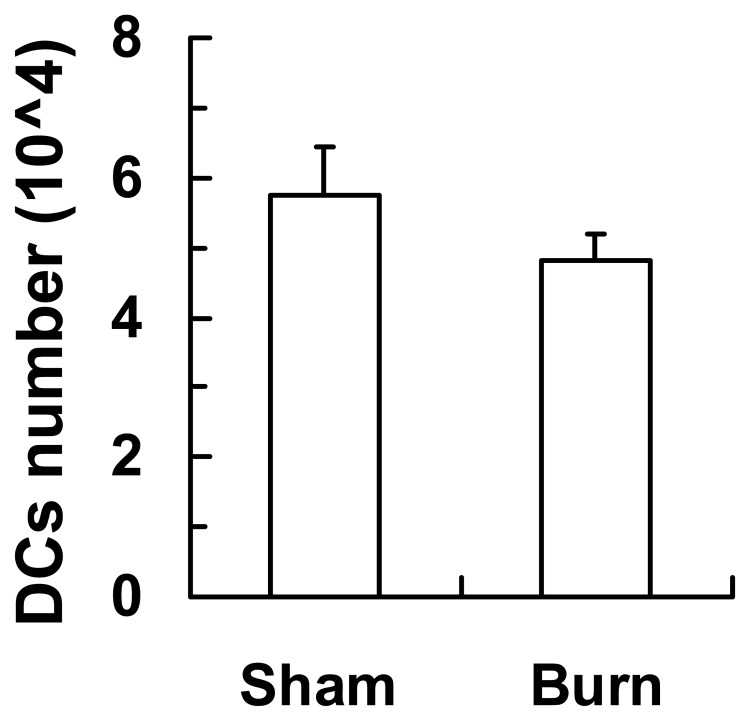
Absolute counts of infiltrating DCs recruited to the burn and sham injury site.Three days post burn injury, the skin specimens of burn and sham injury (2 cm×2 cm) were harvested and digested in Dispase II and collagenase D. Cells were isolated and stained for CD11c+ for DCs followed by flow cytometry analysis. Absolute numbers of infiltrating CD11c+ DCs are shown as mean ± SEM (n = 8, 4 independent experiments).